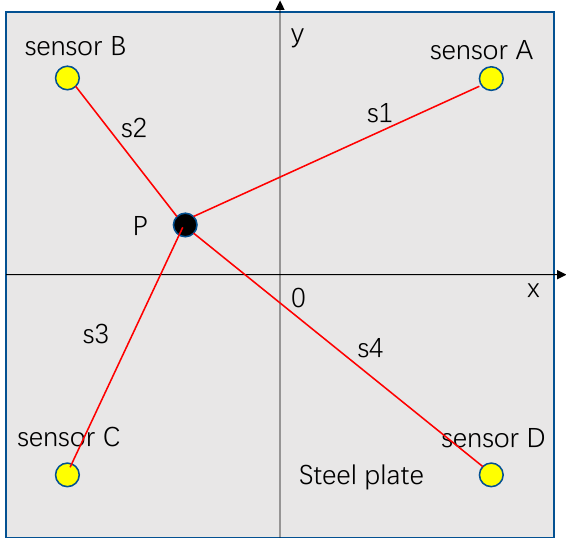
Figure 1. Position distribution of sensors.